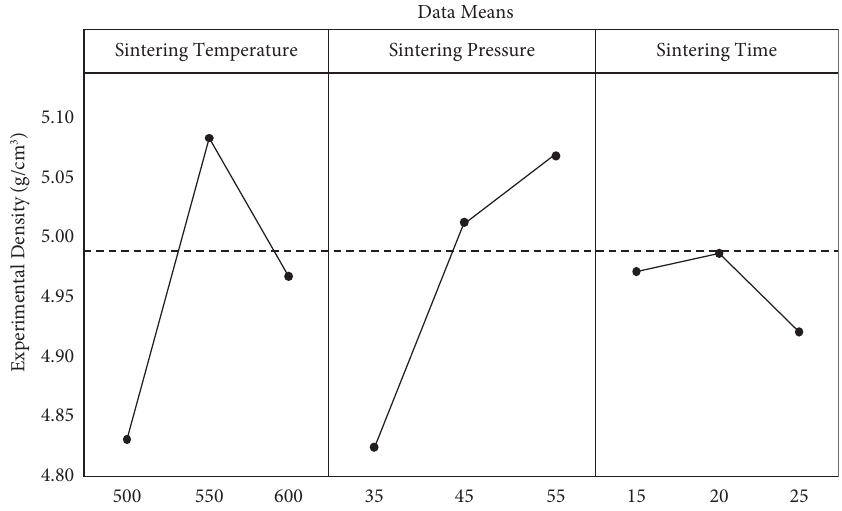
Figure 7: Efect of processing parameters on S/N ratio of experimental density. Table 9: ANOVA analysis for the mean of experimental density.